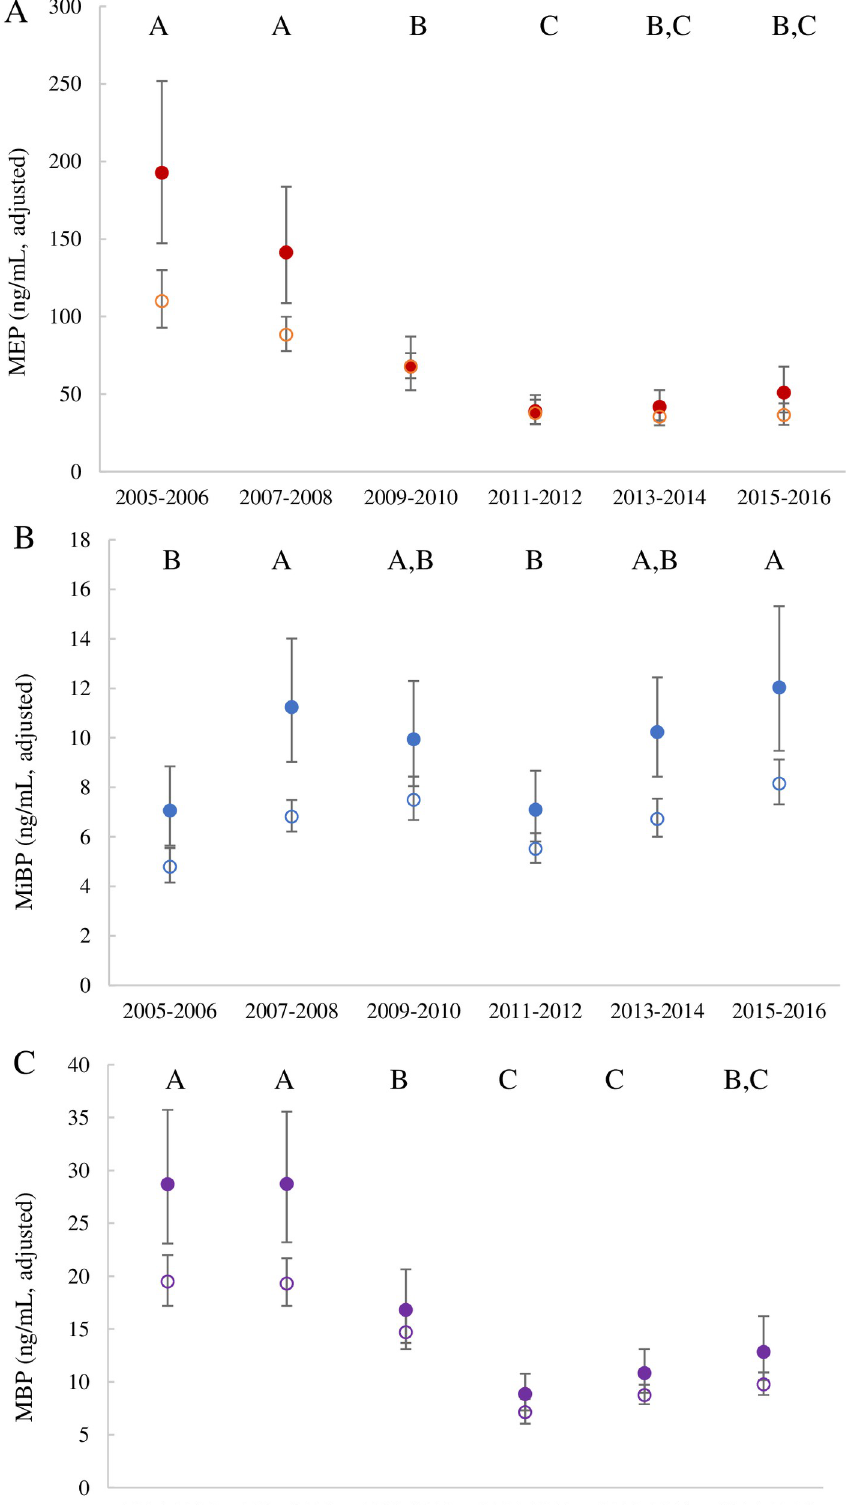
Fig 2. Geometric mean adjusted concentrations for college-aged (18–22 years old) females (filled circles) and for all females (open circles) in NHANES reported in the 4 th National Assessment [22] over time for A) MEP, B) MiBP